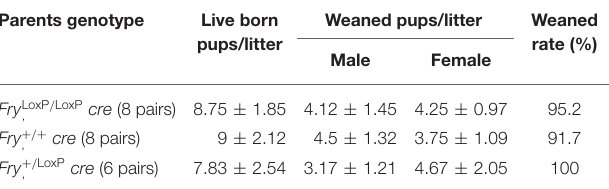
TABLE 1 | Number of live born pups and weaned rate mating from parents of different genotypes. Parents